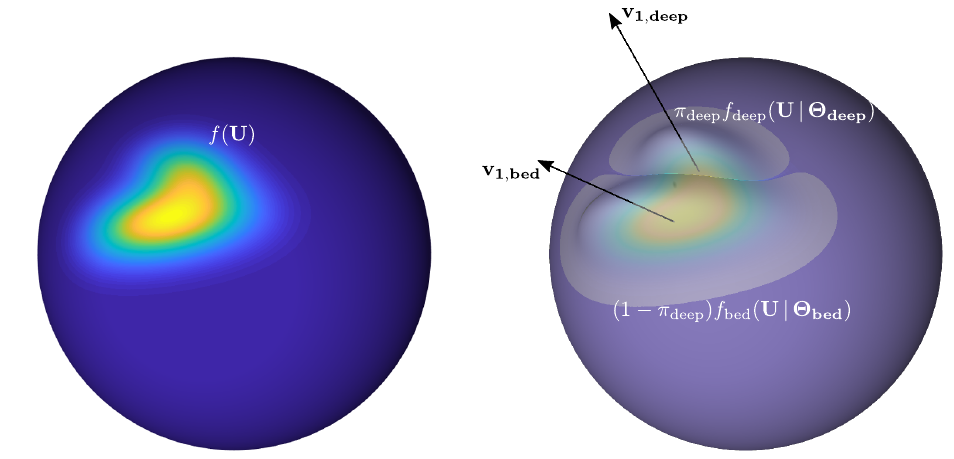
Figure 12. The probability density function f ( U ) of a hue distribution on the sphere ( left ) can be modeled with a mixture of two or more Fisher–Bingham–Kent distributions ( right ). For the distribution of hue over river pixels, we used two components denoted f bed and f deep with respective parameters sets Θ bed and Θ deep : v 1 , bed and v 1 , deep to denote the mean direction of each